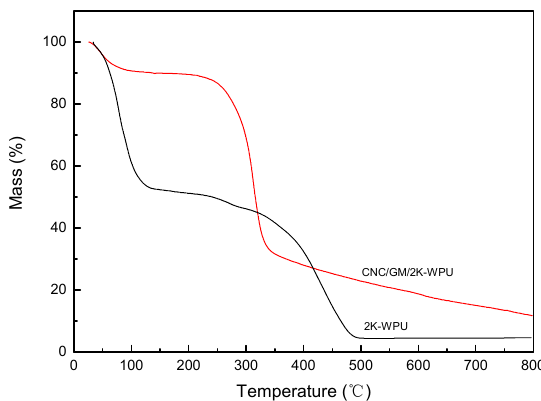
Figure 8. Curves of 2K-WPU and CNC/GM/2K-WPU coatings containing 2 wt % of GM.